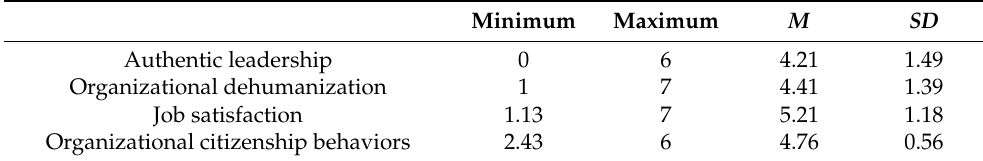
Table 2. Descriptive statistics of the study